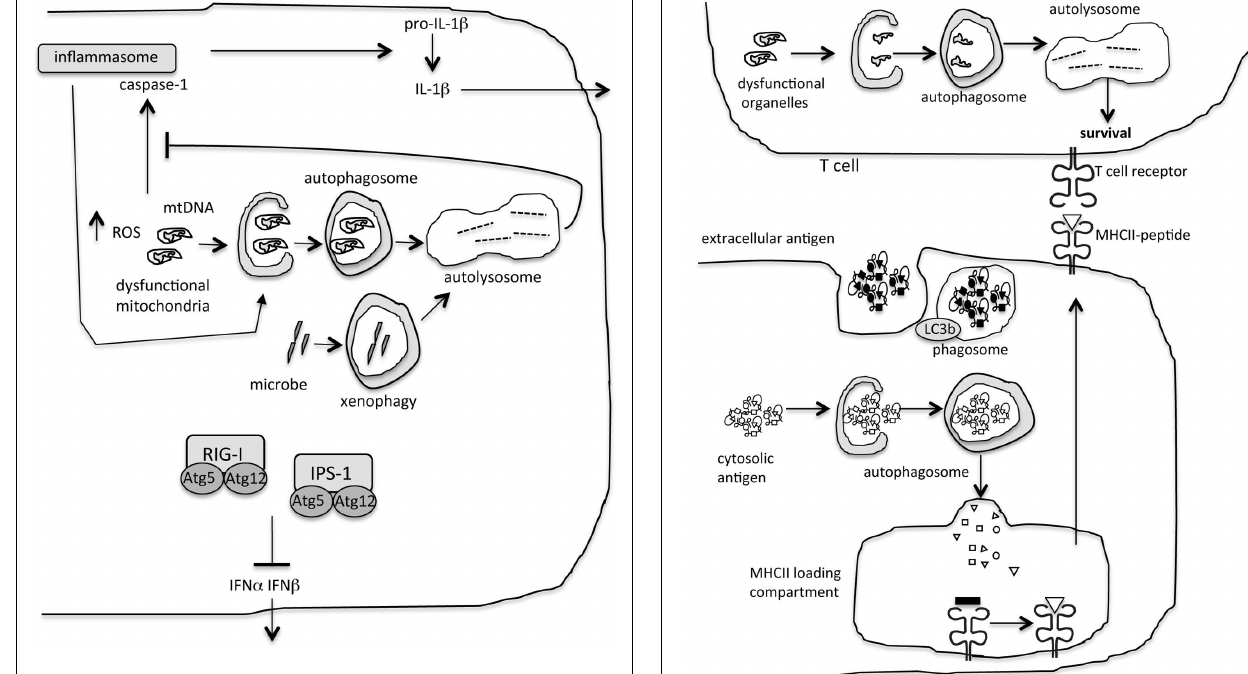
FIGURE 1 | Role of autophagy during innate immunity. “Xenophagy” eliminates intracellular microbes. Autophagy limits inflammatory cytokine production by ensuring removal of dysfunctional organelles, including mitochondria. Accumulation of damaged mitochondria results in increased reactive oxygen species (ROS) and the escape of mitochondrial DNA into the cytosol.These are triggers of the inflammasome and interleukin-1 β (IL-1 β ) production. Inflammasomes are targeted for degradation by autophagy. Proteins in the autophagy machinery bind to and inhibit signaling of key proteins in the type I interferon pathway, retinoic acid inducible gene-I (RIG-I) and the signaling molecule IFN β promoter stimulator-1 (IPS-1).